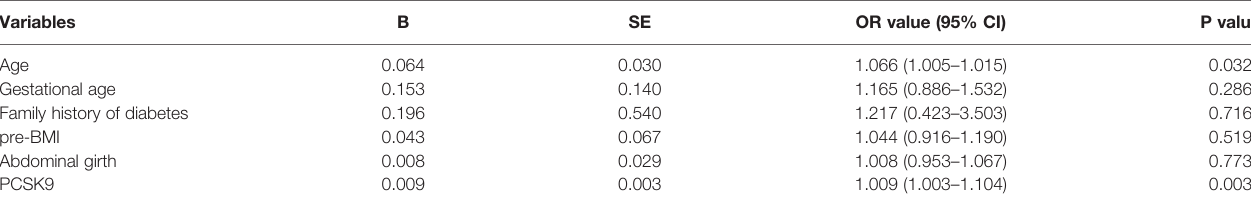
TABLE 3 | Logistic regression analysis on risk factors for gestational diabetes mellitus. Variables